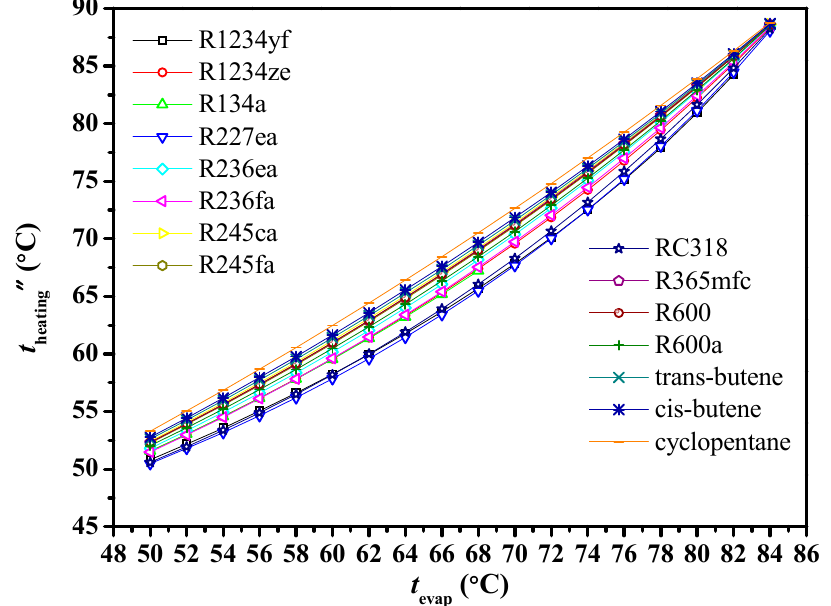
Figure 9. Variation of hot water outlet temperature with evaporating